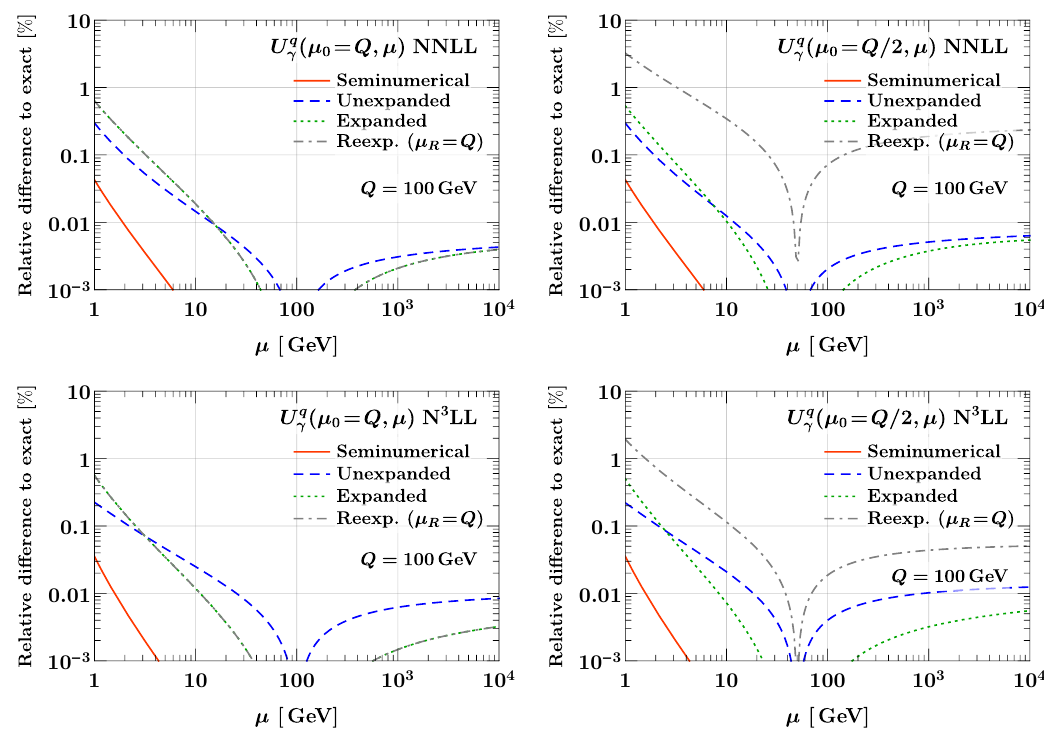
Figure 8 . Same as (cid:12)gure 7, but for the quark noncusp evolution kernels.